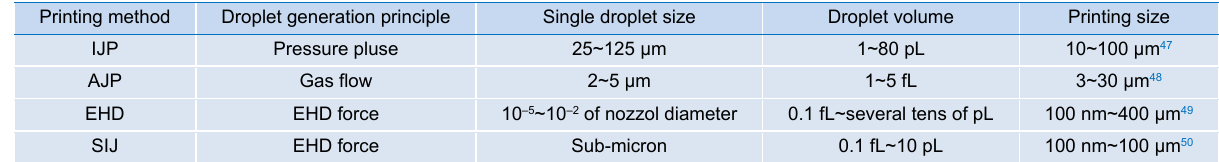
Table 2 | The differences between different printing methods.